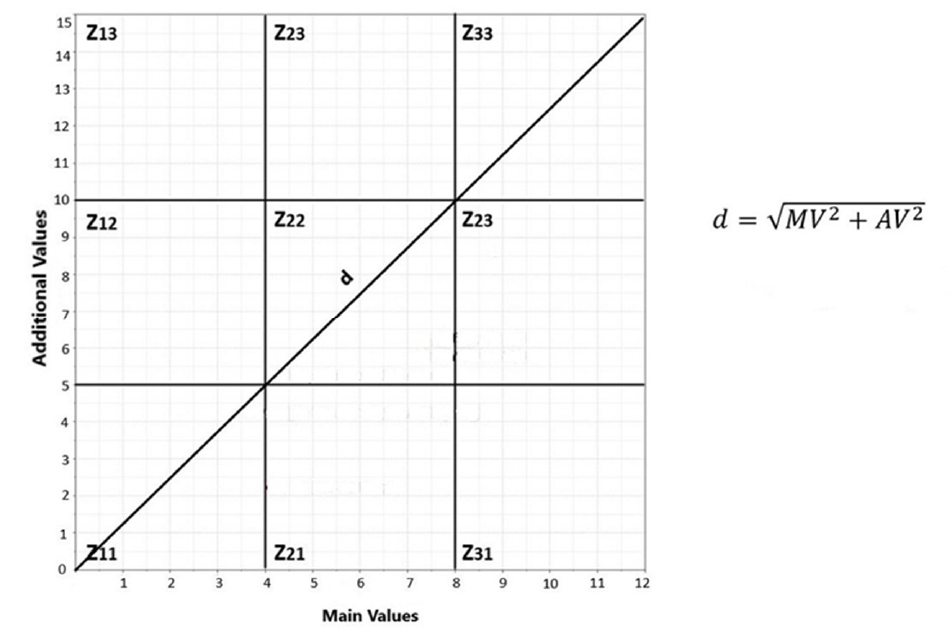
Figure 9. Maximum potential distance from the origin 0 (0,0). In our study, there is a maximum possible value for MV = 12 and AV = 15: (cid:112) ∼ = d max = 12 2 + 15 2 19.2 Finally, the results are converted to a percentage. As a result, size comparisons on a single scale are